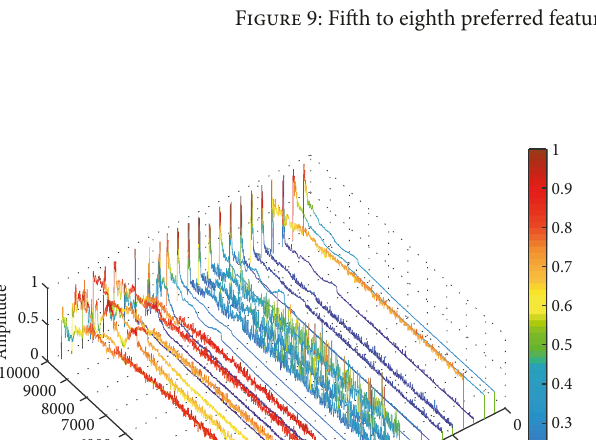
features. On the whole, the predicted results have the same trend as the actual cumulative features, and there are only minor differences between the predicted results and actual cumulative features.